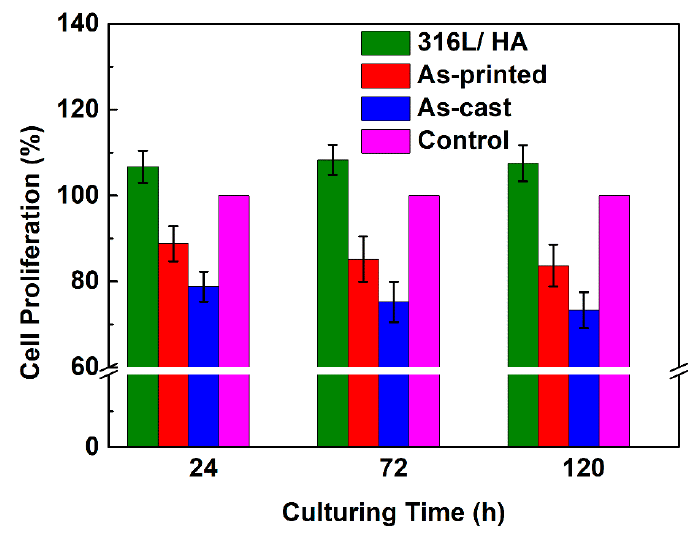
Figure 11. HA coating thickness ( a ) 1 mg/mL solution ( b ) 5 mg/mL solution, and surface morphology